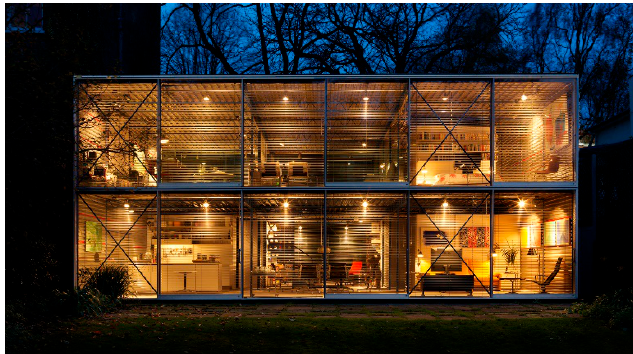
Figure 6. Michael and Patty Hopkins House, 1975–1976 [12].